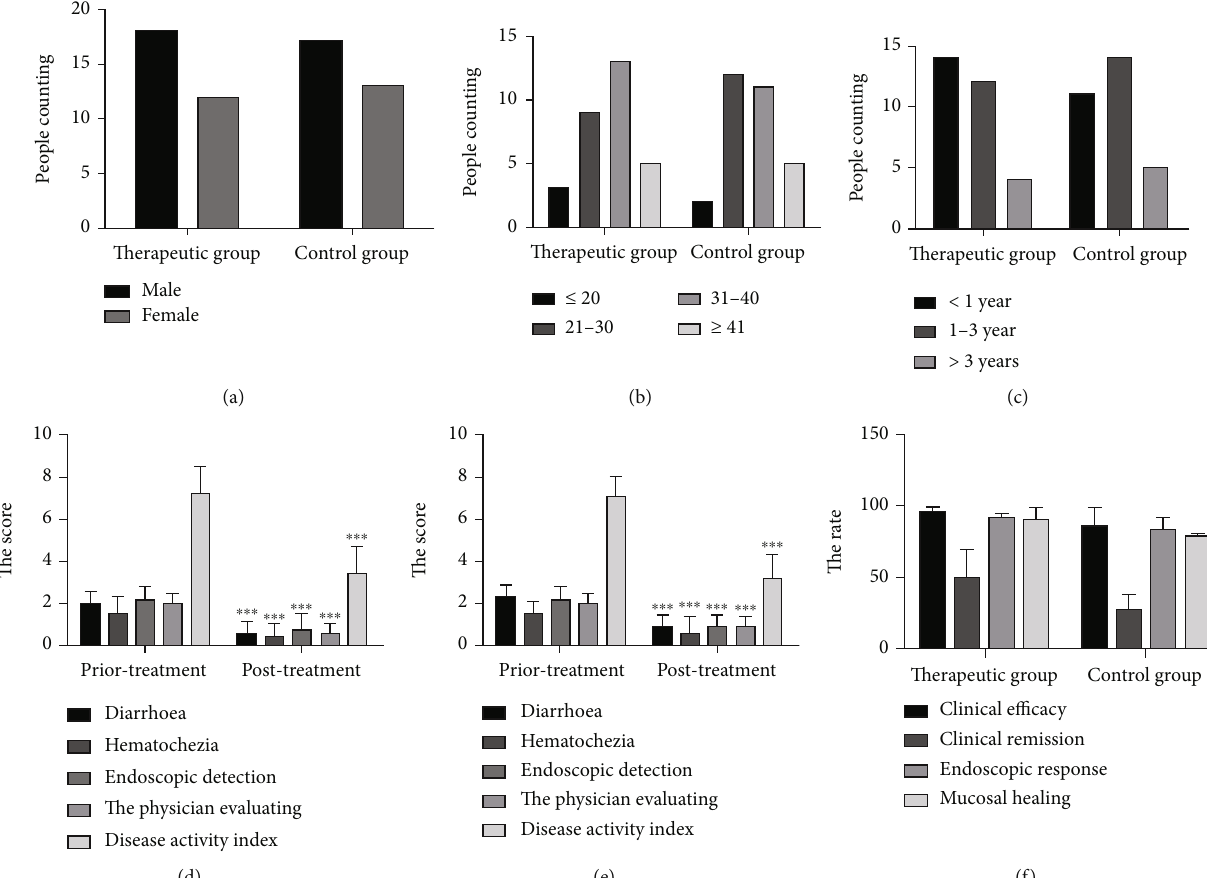
Figure 1: Qinghua Jianpi Recipe has a signi fi cant clinical e ff ect on ulcerative colitis. The fi gure shows the gender (a), age (b), and disease duration (c) of the enrolled patients. The therapeutic group and control group patients, in the application of Qinghua Jianpi Recipe before (e) and after (d) treatment, get diarrhea, hematochezia, endoscopic detection, physician evaluation, and disease activity score. The clinical e ff ective rate, clinical remission rate, endoscopic response rate, and experience healing rate of the therapeutic group and the control group were analyzed (f). ∗∗∗ P < 0 : 001 , the di ff erence was statistically signi fi